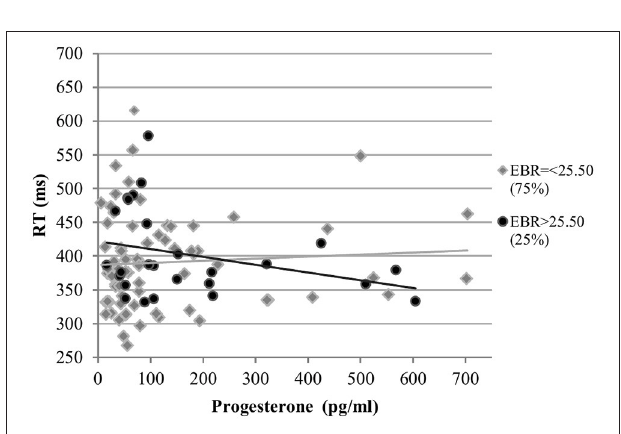
FIGURE 9 | Interactive effects of progesterone and EBR on reaction time (RT) for Stroop color. Women with lower EBR during menses were slower the higher their progesterone levels, whereas women with higher EBR during menses were faster as their progesterone levels